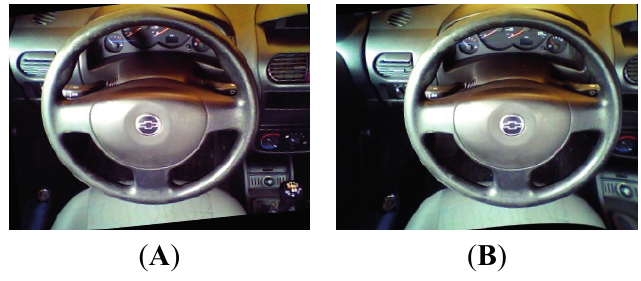
Figure 1. Images from testing samples in cabin. ( A ) Left camera ( B ) Right camera.